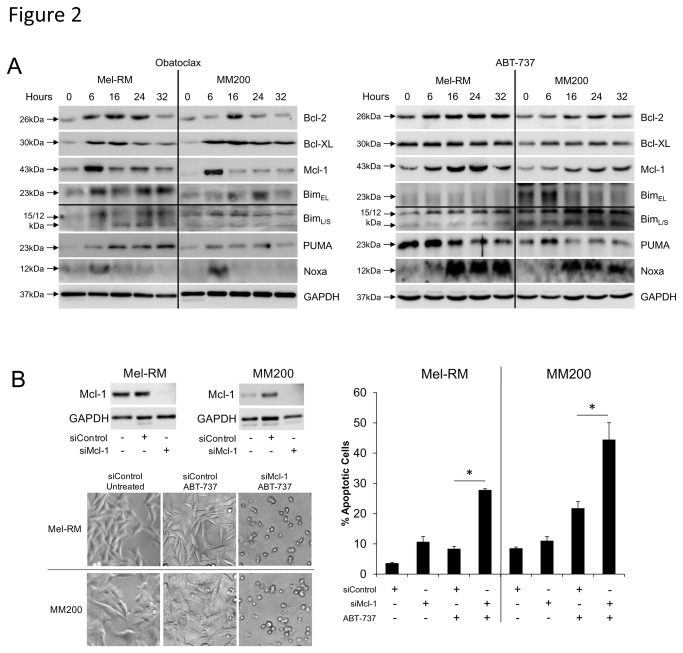
Obatoclax and ABT-737 induce regulation of Bcl-2 family proteins.A. Upregulation of BH3-only proteins and anti-apoptotic Bcl-2 family proteins occurs in response to Obatoclax. Whole cell lysates of Mel-RM and MM200 cells were subjected to Western blot analysis following treatment with Obatoclax (1µM) or ABT-737 (10µM) for indicated periods. Data are representative of three individual experiments.B. Knockdown of Mcl-1 increases cell sensitivity to ABT-737. Mel-RM and MM200 cells were transfected with either control or Mcl-1 siRNA before treatment with ABT-737 (10μM) for 24 hours. Cells were then subjected to measurement of apoptosis by the propidium iodide method. Columns, mean of three individual experiments; bars, SE. Knockdown of Mcl-1 was confirmed by Western blotting. Photographs representative of cell population at 24 hours are displayed and are representative of three individual experiments.